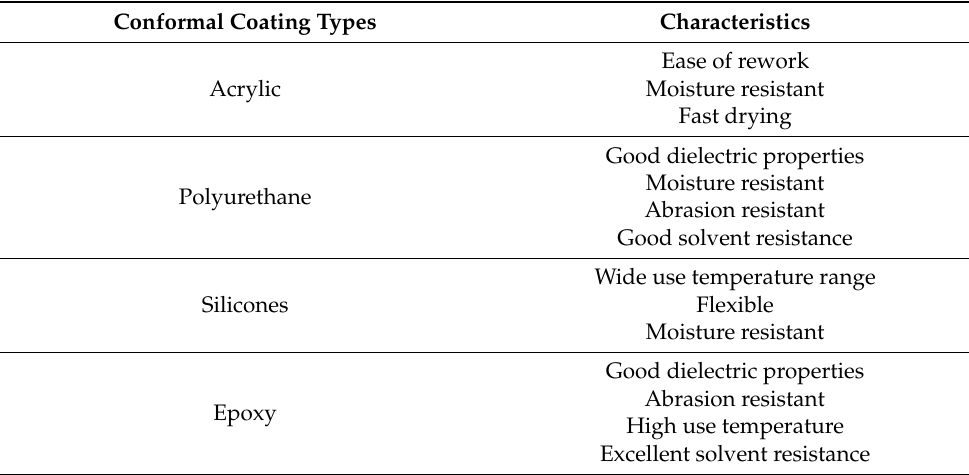
Table 5. General characteristics for conformal